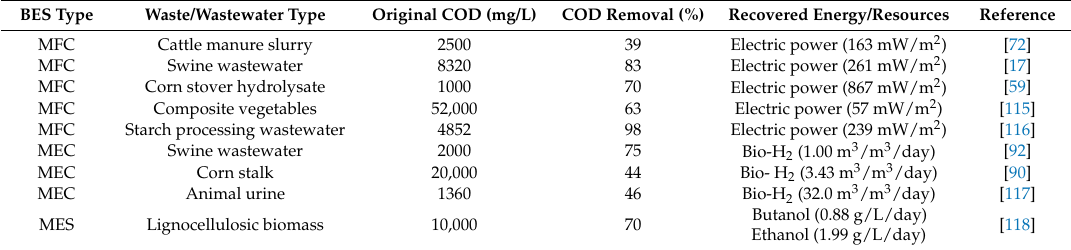
Table 4. Performance comparisons of bioelectrochemical systems (BESs) for treating agricultural